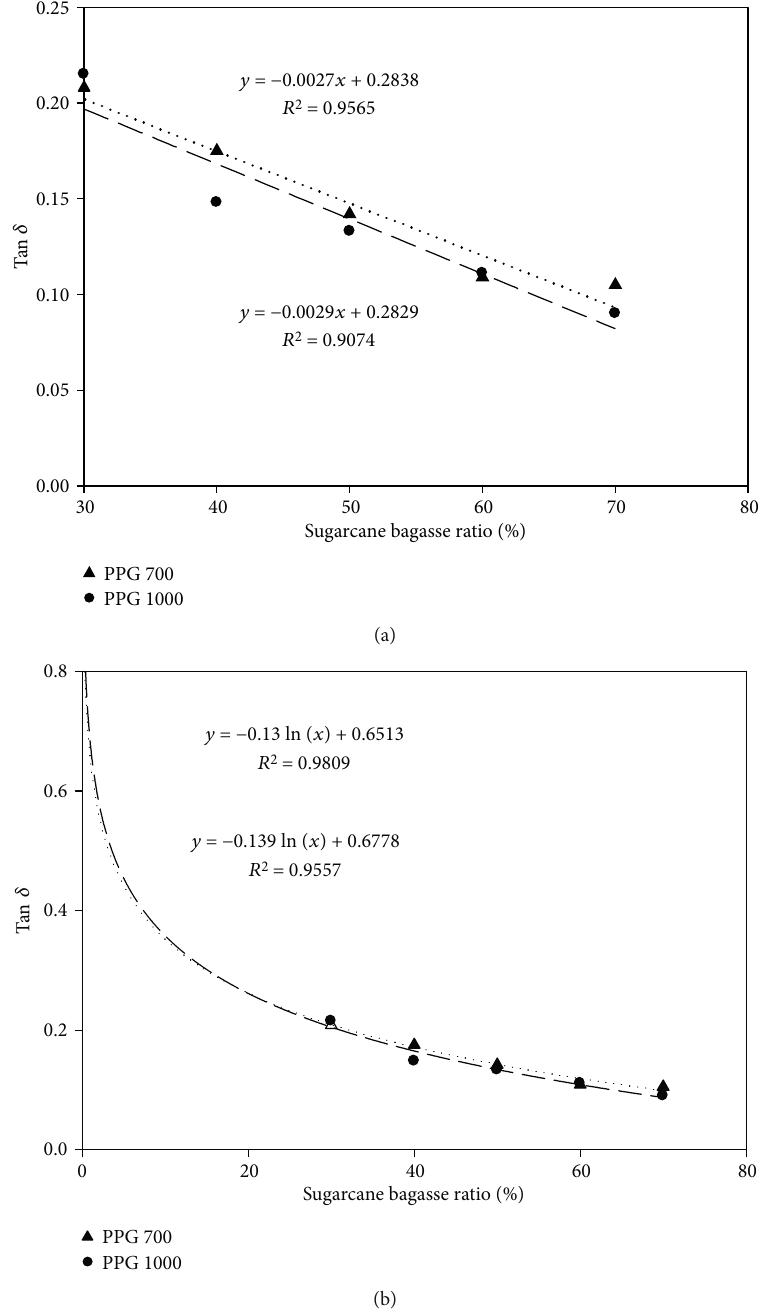
Figure 7: (a) Linear relationship between sugarcane ratio and tan δ peak value. (b) Logarithm relationship between the sugarcane ratio and tan δ peak